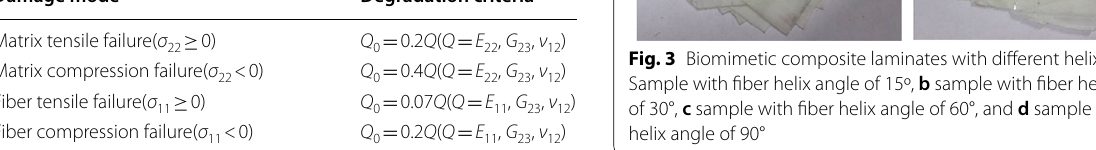
Table 3 Material stiffness degradation criterion Damage mode